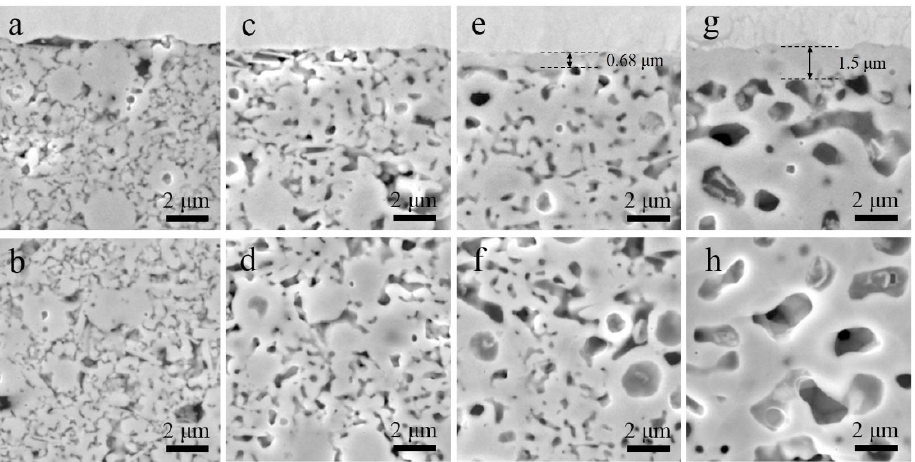
Figure 3. The microstructure of Ag nano paste joint on different temperatures after sintering for 2 h: ( a ) interfacial and ( b ) bonding microstructure at 150 °C; ( c ) interfacial and ( d ) bonding microstructure at 200 °C; ( e ) interfacial and ( f ) bonding microstructure at 250 °C; ( g ) interfacial and ( h ) bonding microstructure at 300 °C.